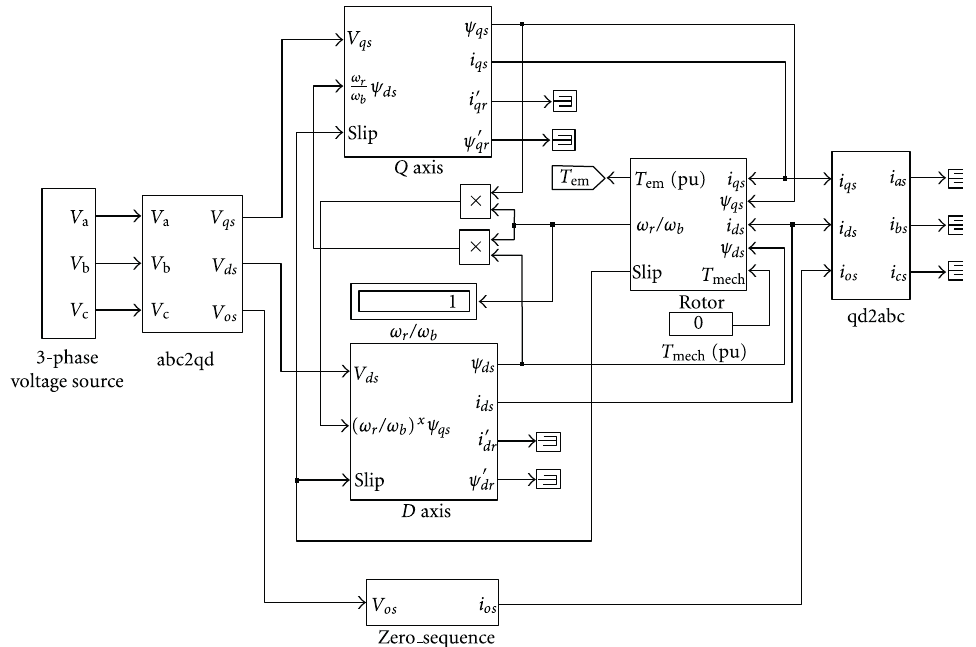
F 5: A dynamic modelling block diagram of a hysteresis motor in